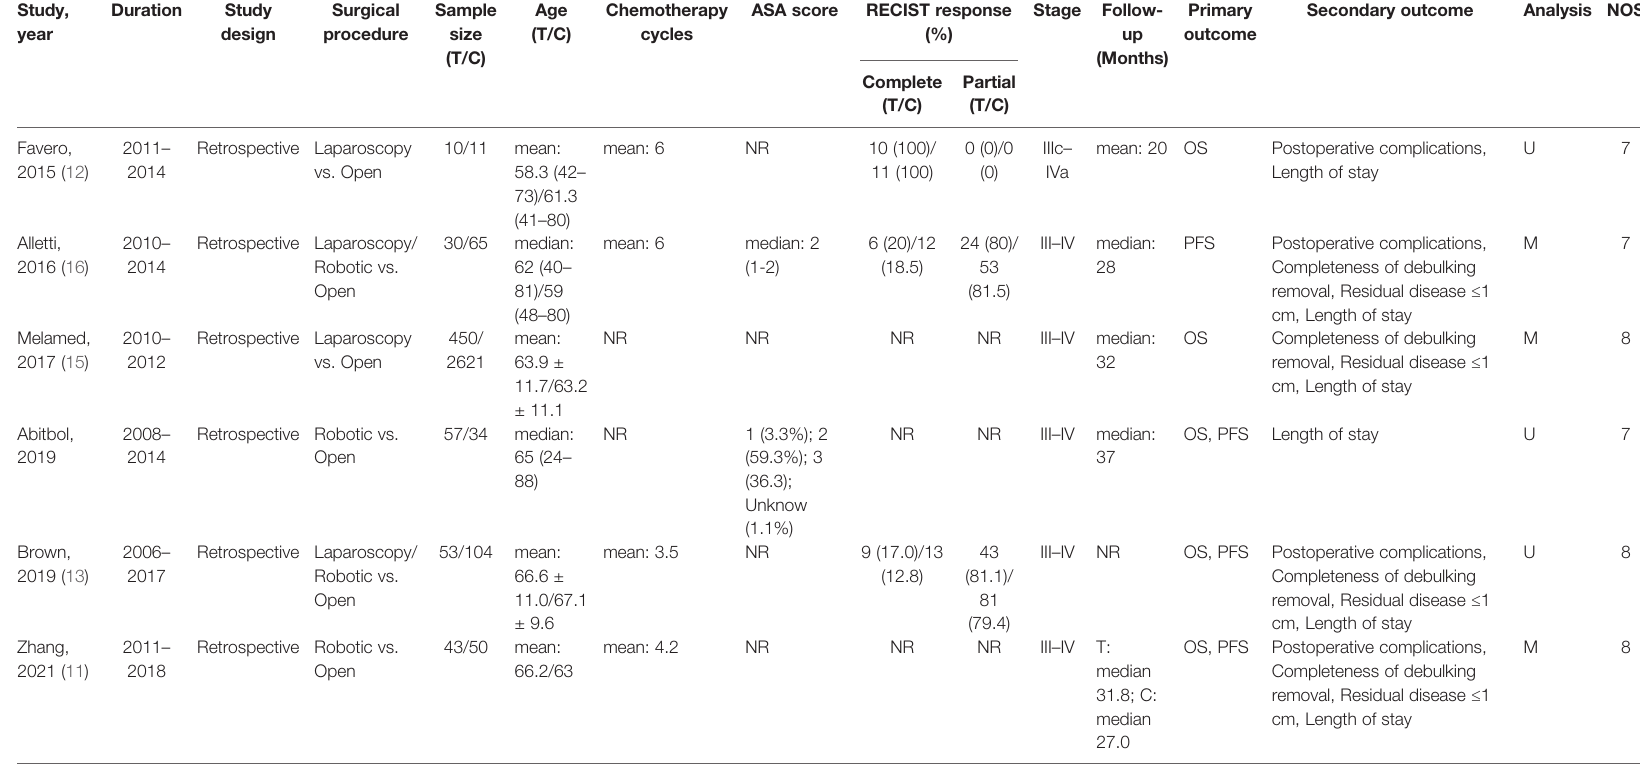
TABLE 1 | Characteristics of studies included in this